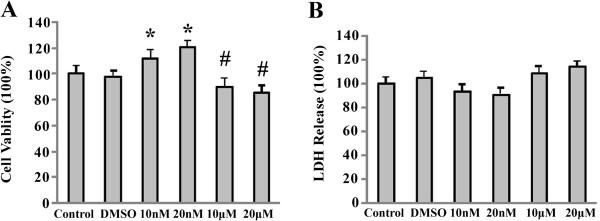
The effects of different doses of E2 pre-treatment on PC12 cell viability and cell damage. (A) MTT assay was used to test the cell viability after OGD-R. 10 nM and 20 nM E2 significantly promoted the cell viability. The cell viability in the cells treated with 10 μM and 20 μM E2 group significantly decreased. (*p < 0.01 compared with the control and DMSO groups, #p < 0.05 compared with the control and DMSO groups). (B) LDH release assay was used to detect cell necrosis after OGD-R. 10 nM and 20 nM E2 did not significantly attenuate LDH release; and 10 μM and 20 μM E2 the LDH release in group had not markedly declined (v.s. the control and DMSO groups).